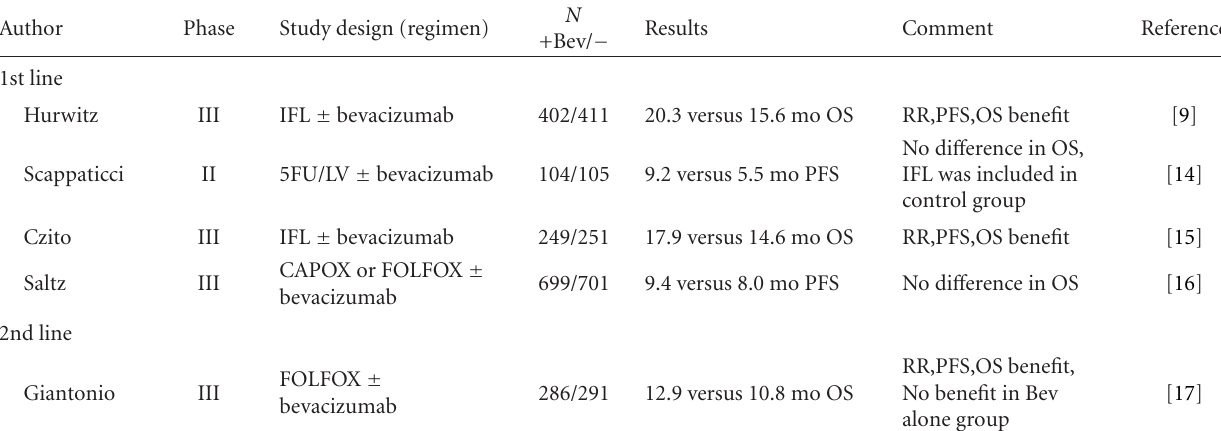
Table 1: Pivotal randomized clinical trials of bevacizumab in mCRC.